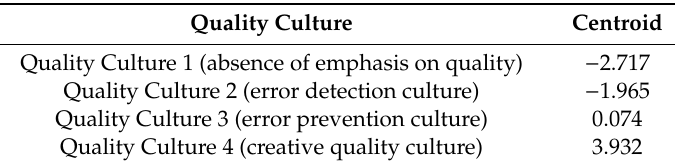
Table 17. The centroids of quality cultures.